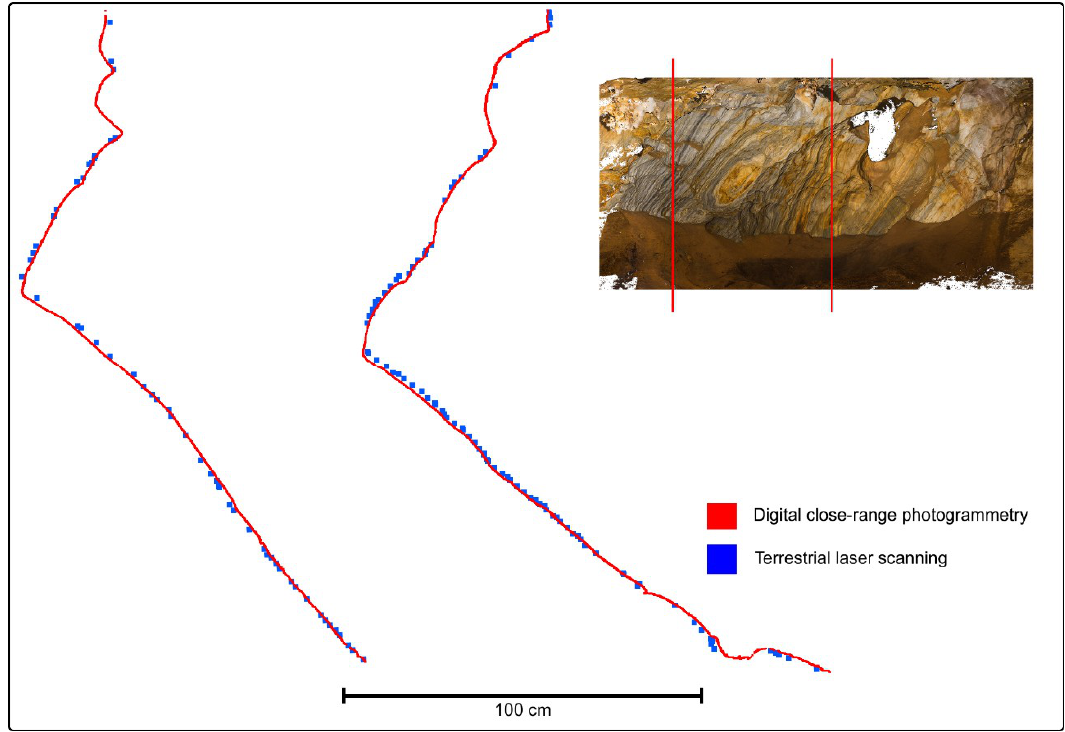
Figure 14. Two vertical cross-sections through both point clouds with their location.